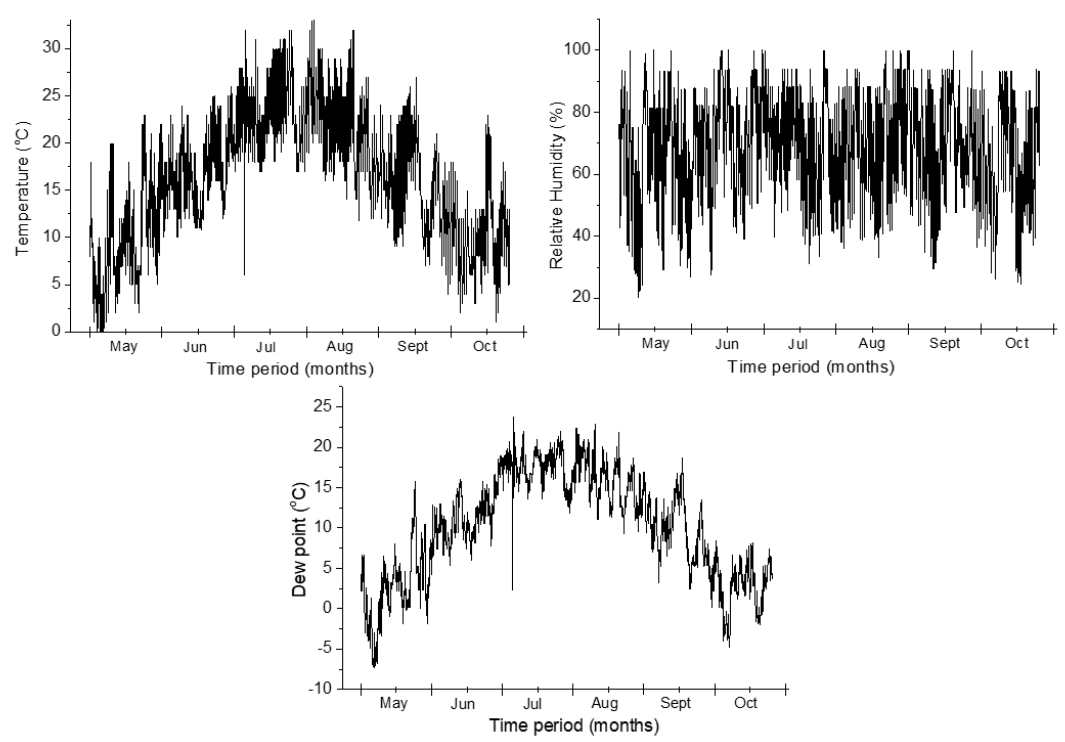
Figure 13. Environmental parameters from the MSMN (temperature, relative humidity, and dew point).